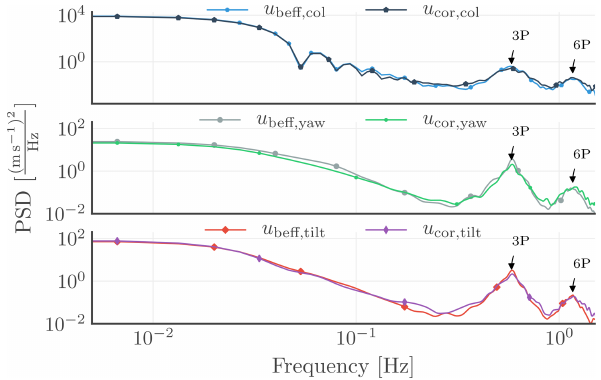
Figure 12. Power spectral densities of the blade effective wind speeds ( u beff ,k ) and the corrected inflow wind speeds ( u cor ,k ) in the non-rotating frame of reference, with k ∈ { col, yaw, tilt }